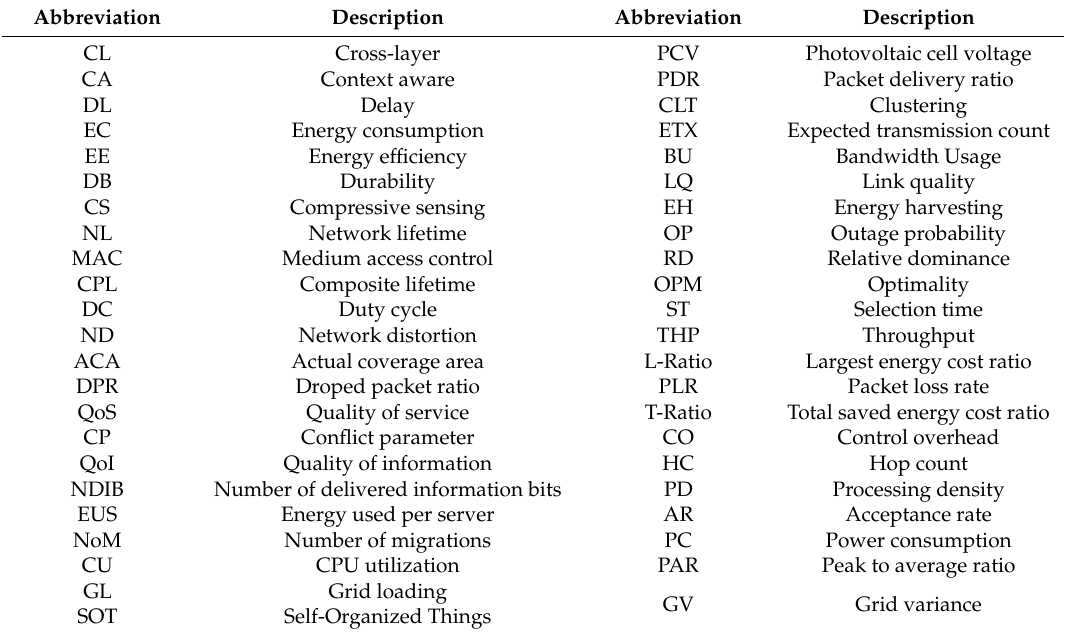
Table 3. Abbreviations used in comparison